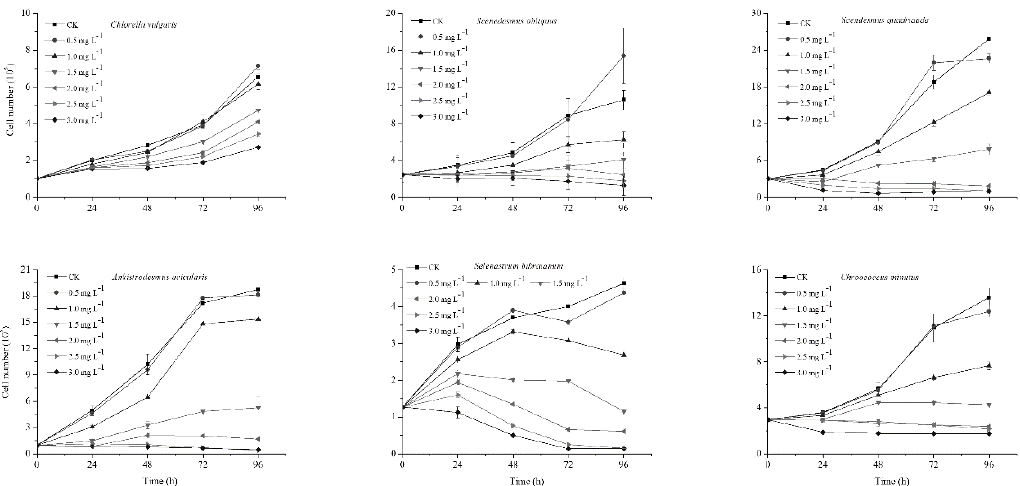
Figure 1. E ff ect of nonylphenol (NP) on the cell number of microalgae. Algae were treated with NP at